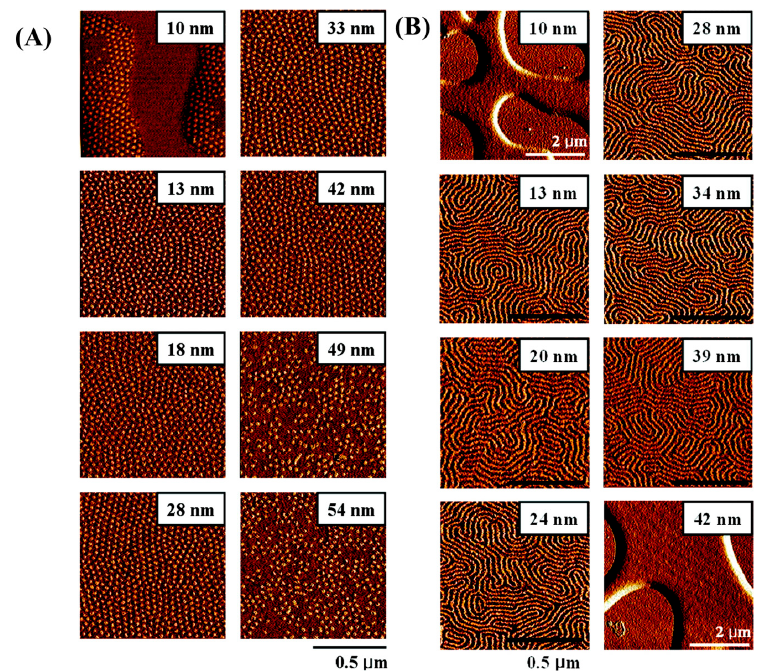
Figure 17. Surface force microscopy (SFM) phase image of ( A ) cylinder-forming PS- b -PMMA and ( B ) lamella-forming PS- b -PMMA on the substrate modified by R64 (PS mole fraction of 0.64) and R55 (PS mole fraction of 0.55), respectively, at various film thicknesses of block copolymer after thermally annealing thin films at 170 °C for 24 h. Reprinted from Reference [119]. (Copyright (2008) American Chemical Society).